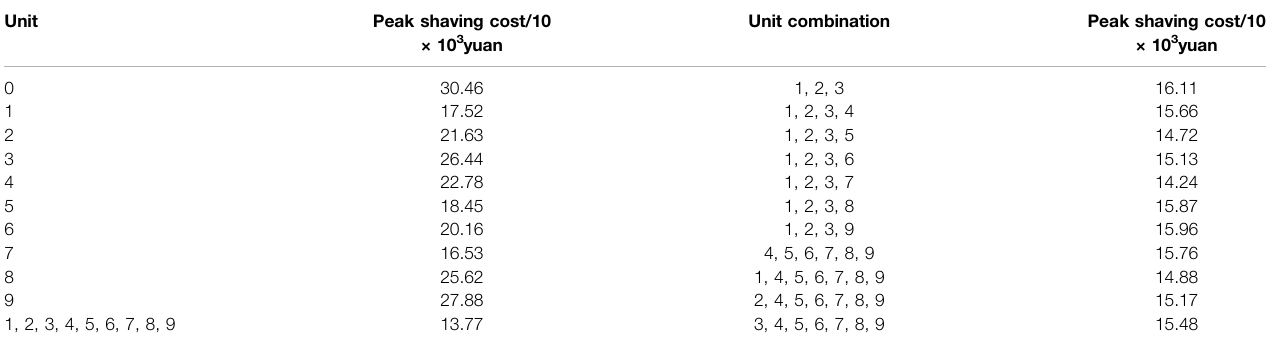
TABLE 2 | Peak shaving cost of each unit in the joint peak shaving unit. Unit